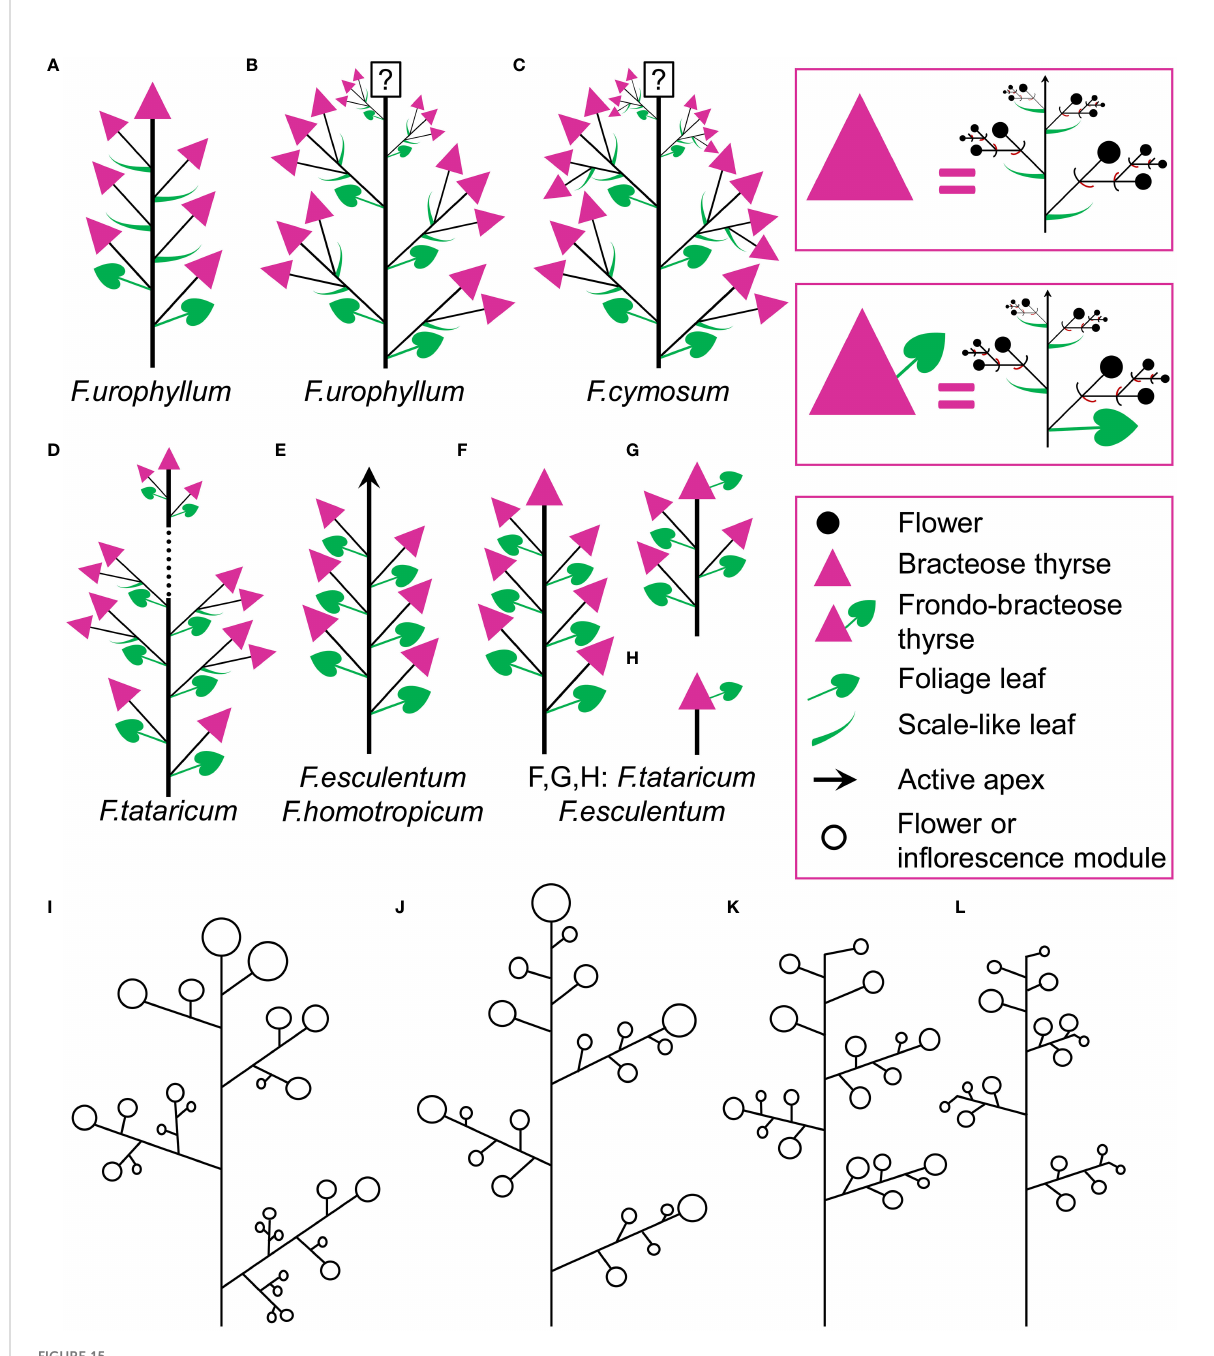
FIGURE 15 (A – H) Diversity of fl owering units in Fagopyrum species studied here. Diagrams are simpli fi ed with respect to variation in number of branches on the main axis. Questions marks denote the absence of data on the latest developmental stages. (I – L) Typical scenario of angiosperm in fl orescence evolution (from I to L) proposed in the framework of the so-called Pseudocycle Concept (modi fi ed from Kusnetzova, 1988). Circles may represent fl owers or more complex aggregations of fl owers (e.g. thyrses in Polygonaceae: Yurtseva, 2006). Although the Pseudocycle Concept is problematic in many respects, especially in the proposed unidirectional nature of its transformation series, the branching patterns included in the diagram appear to represent some ‘ privileged ’ types that tend to occur more commonly than other types among angiosperms, possibly for reasons of physiological regulation of in fl orescence